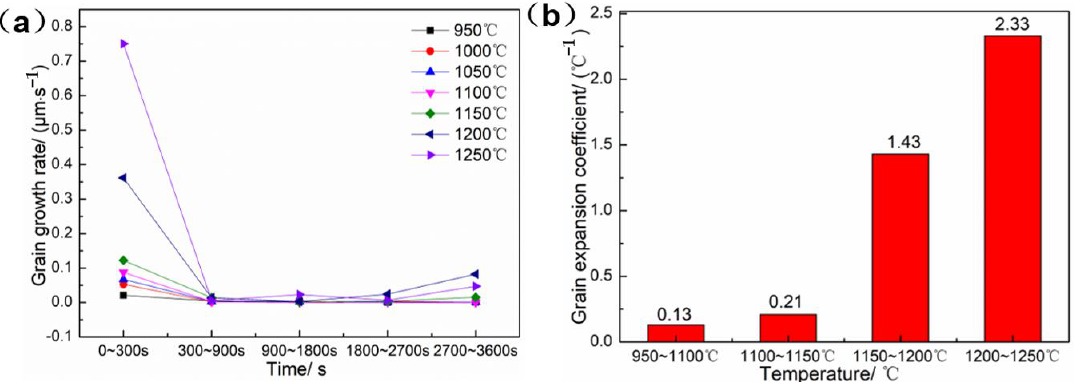
Figure 6. The grain growth rate ( a ) and the grain expansion coefficient ( b ) of the GH3625 sheet.